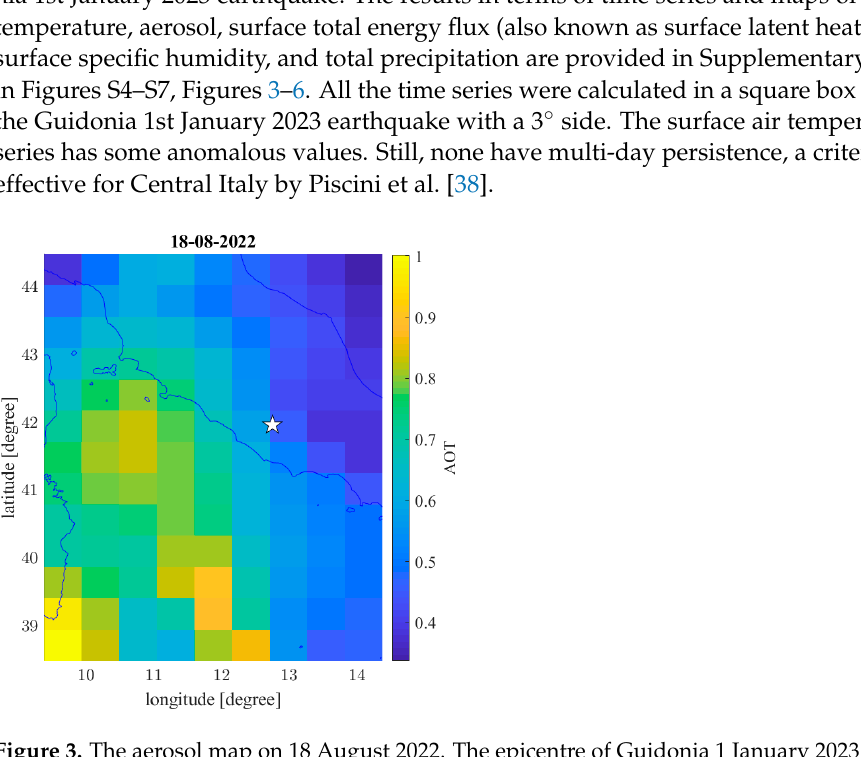
Figure 4. Total latent energy flux time series from 4 July 2022 to 31 December 2022 (i.e., from six months before until the day before the ML = 3.3 Guidonia 1 January 2023 earthquake, red dashed line). The blue line represents the historical mean calculated from 1980 to 2021 in the same period and region. Cyan, green, and yellow bands represent 1.0, 1.5, and 2.0 standard deviations of the